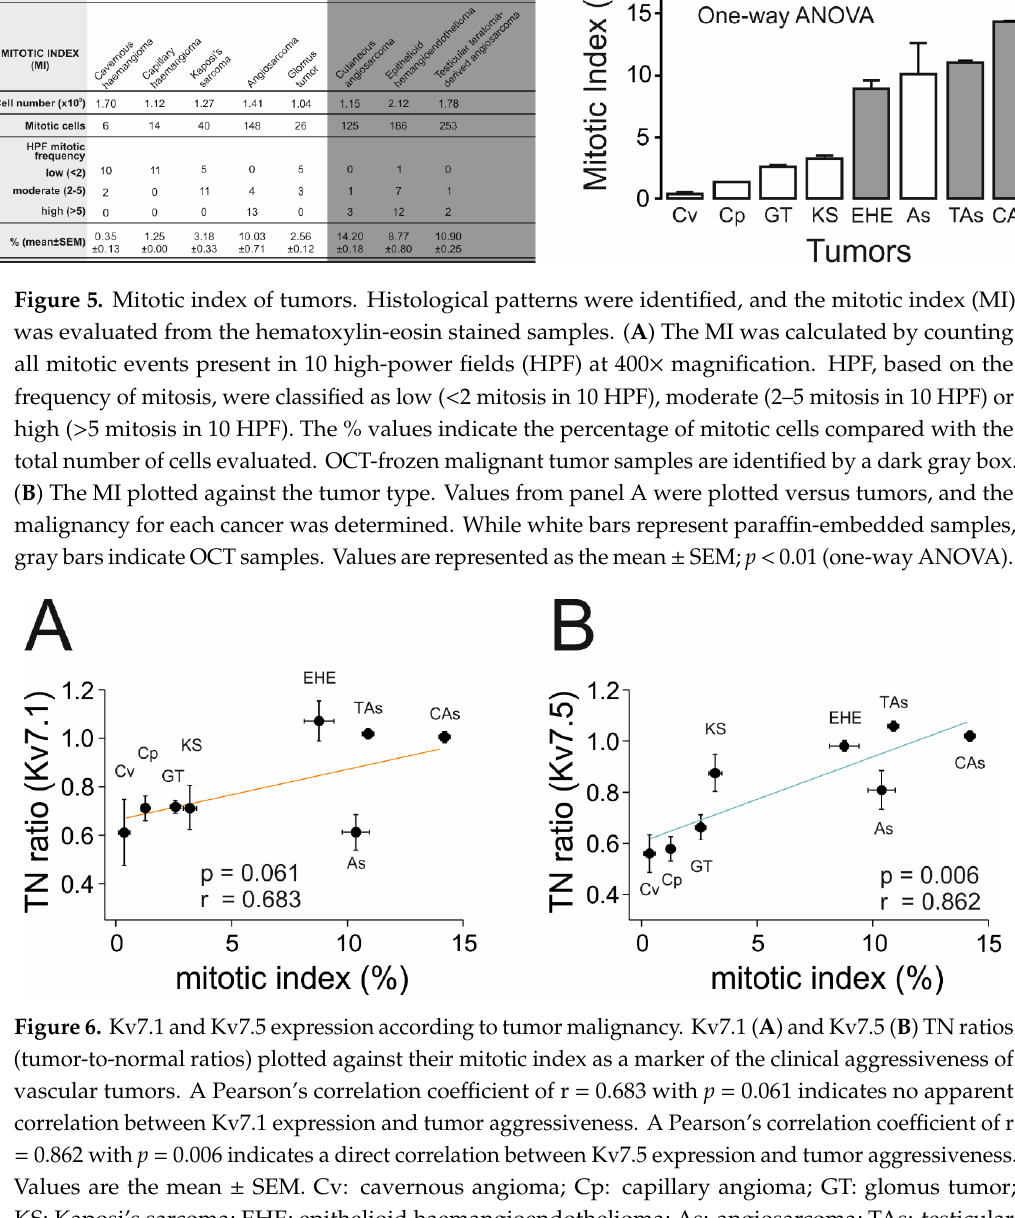
samples, gray bars indicate OCT samples. Values are represented as the mean ± SEM; p < 0.01 (one- way ANOVA).